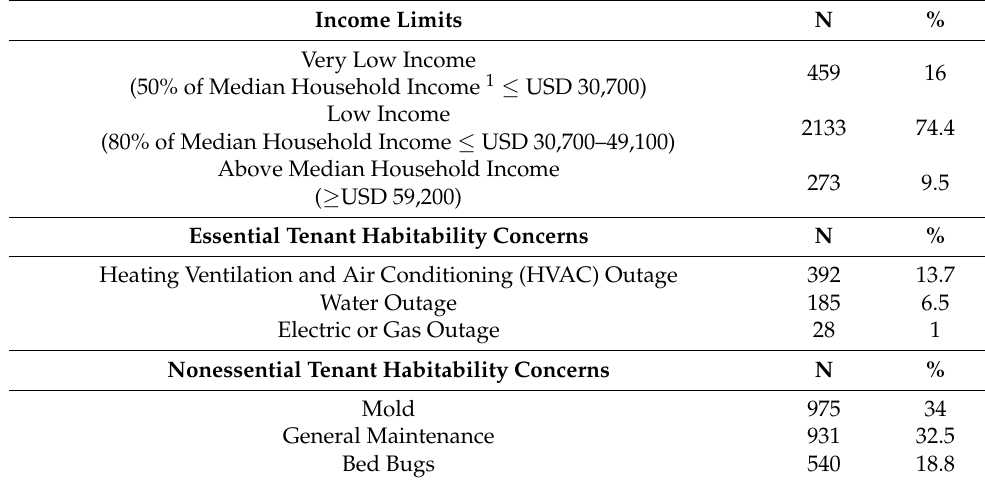
Table 1. Summary of complaints by ZIP code median income and essential and nonessential services from 2865 calls made to the Clark County Landlord–Tenant Hotline (CCLTH) between May 2011 and April